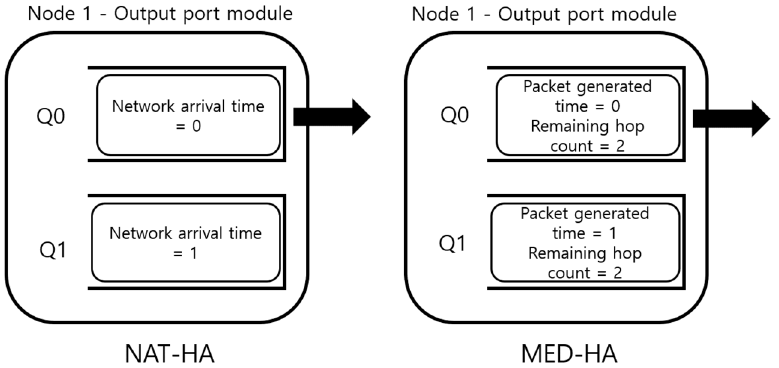
Figure 7. In the example topology, when packets want to go out simultaneously from node 1 at time T, the service of each heuristic algorithm is displayed.